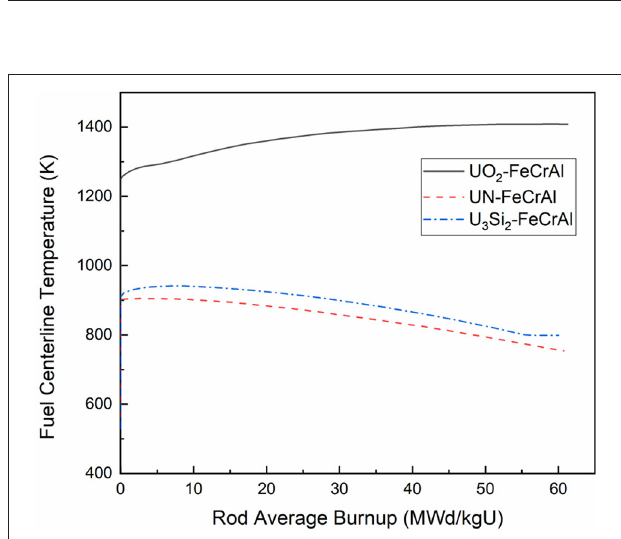
FIGURE 5 | Comparison of fuel centerline temperature of UO 2 , UN, and U 3 Si 2 with the FeCrAl